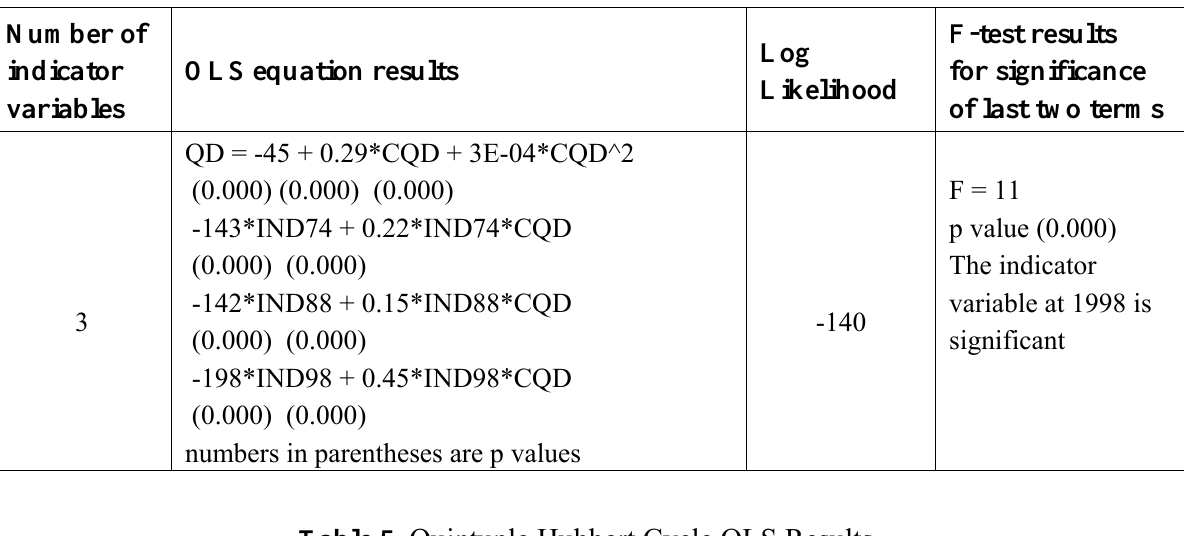
Table 4. Quadruple Hubbert Cycle OLS results.